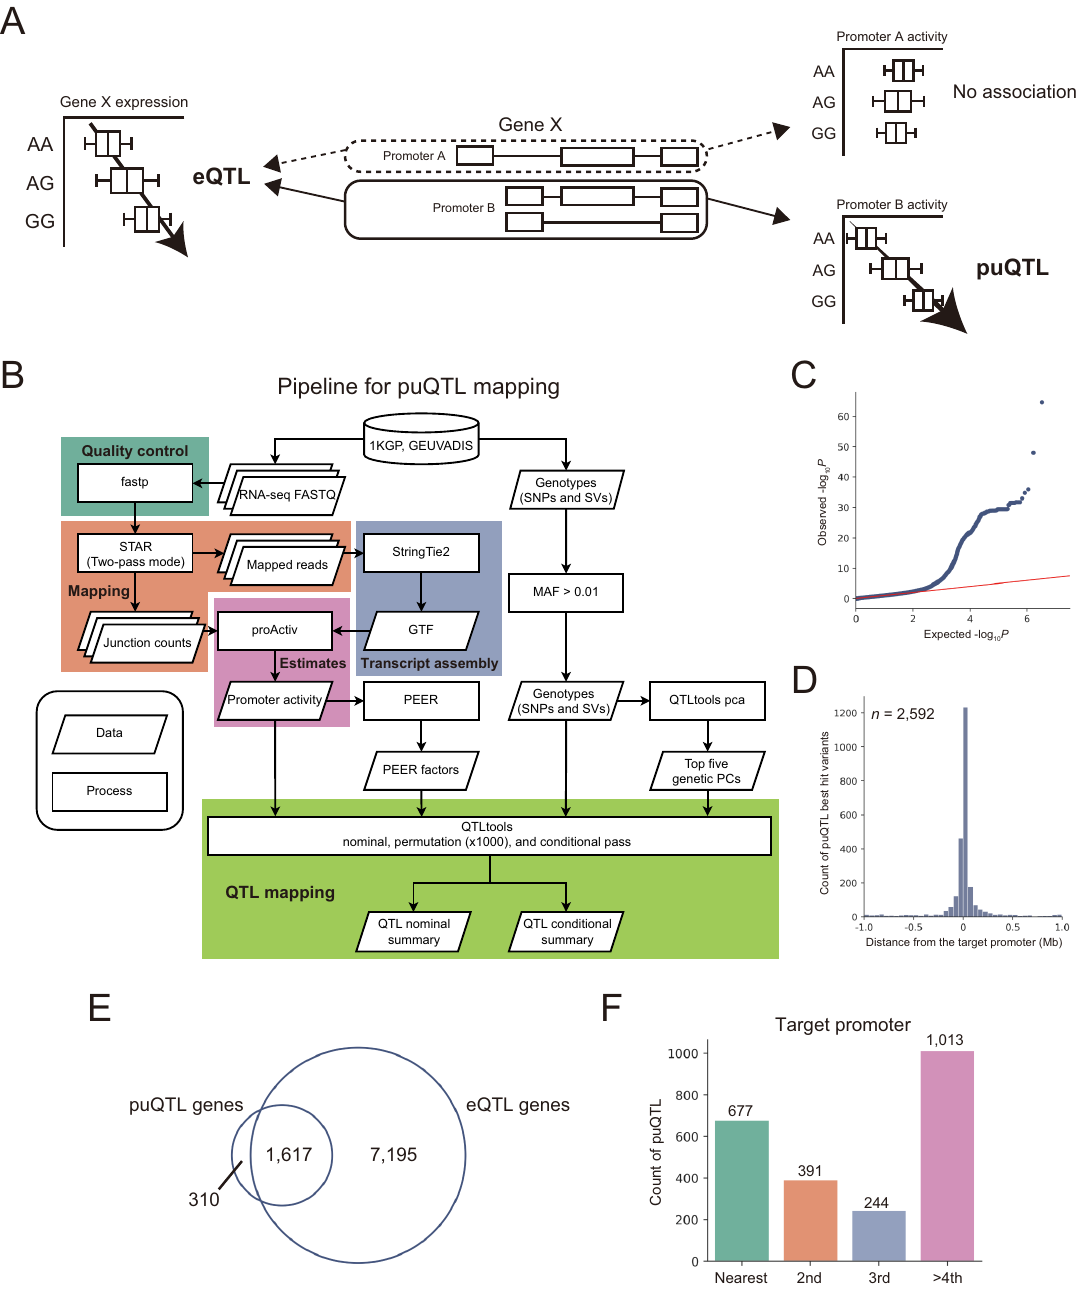
Fig 1. puQTL mapping using RNA-seq data. (A) Schematic view of eQTL and puQTL mapping. (B) Pipeline for puQTL mapping. 1KGP, the 1000 Genomes Project; MAF, minor allele frequency; GTF, gene transfer format. (C) Quantile–quantile plot of P -values. The nominal pass results of chromosome 22 are plotted, and the red line indicates the expected P -values under the null hypothesis. (D) Distribution of the distance of puQTL best hit variants from the target promoters. (E) Overlap of puQTL genes and eQTL genes. (F) Counts of puQTL associated with multi-promoter genes based on categories of proximity to their target promoters. “Nearest” means that the puQTL targets the nearest promoters of the associated genes, “2nd” means that they target the second nearest promoters, and so